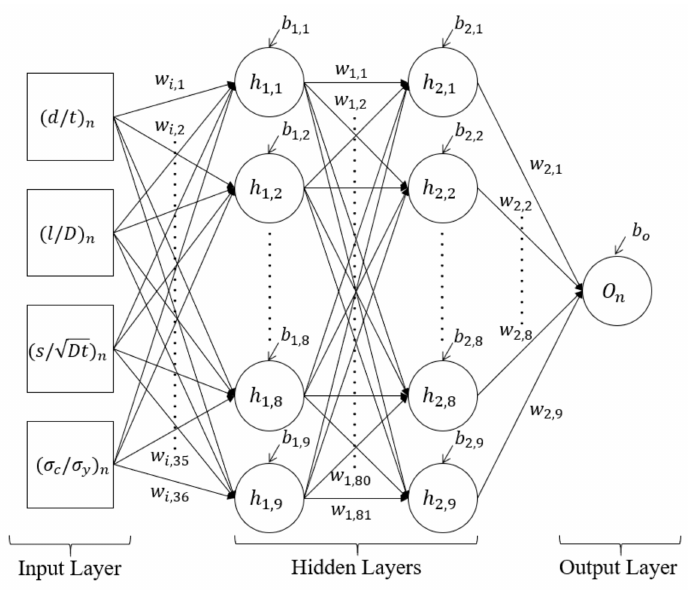
Figure 14. Architecture of FFNN model employed. The weights and biases of the links were constantly updated until the training stopped when the predictions from the ANN achieved the target error difference with an R 2 of 0.9997, MSE of 7.067 × 10 − 5 and MAE of 0.0067. Weights and biases from the trained ANN model were expressed in mathematical form from Equations (11)–(13) to formulate the failure pressure prediction